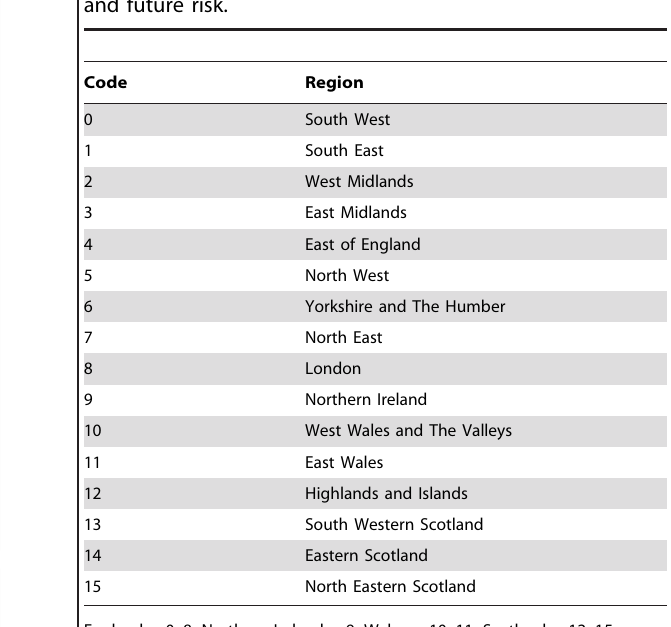
Table 1. The 15 regions of the UK used in comparing past and future